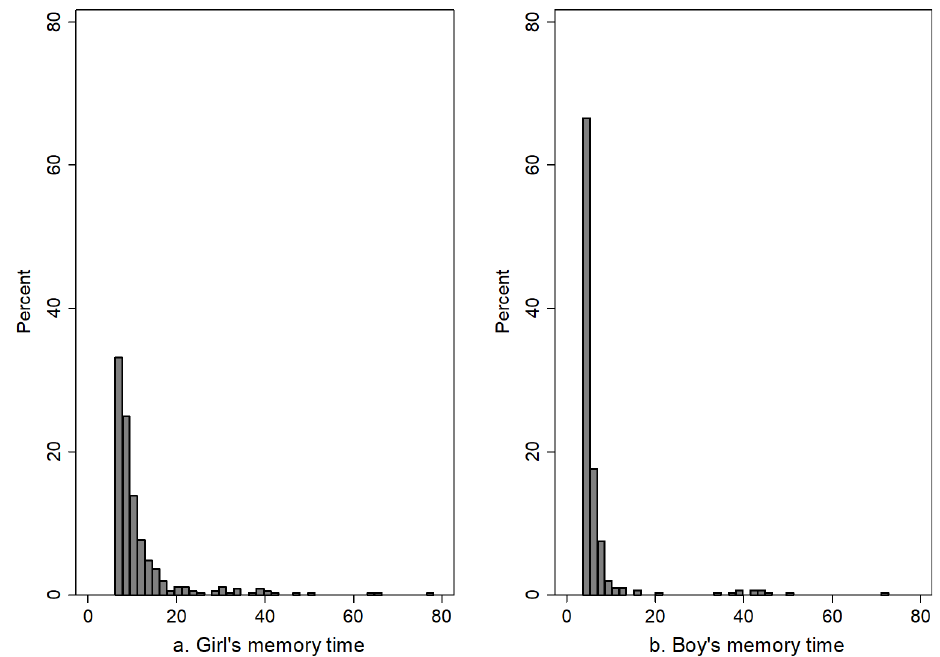
Fig 2. Distribution of memory time for girls and boys.